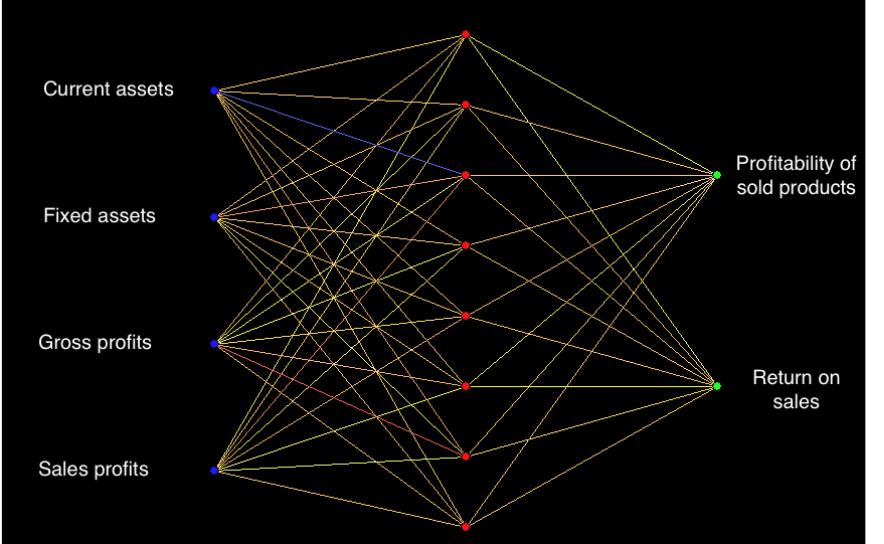
Figure 10. Graph of a neural network with architecture 4-8-2, constructed in Deductor Studio (dependence of the performance indicators of the microindustrial system on the input variables DFA , VSG , VIG , RW ).